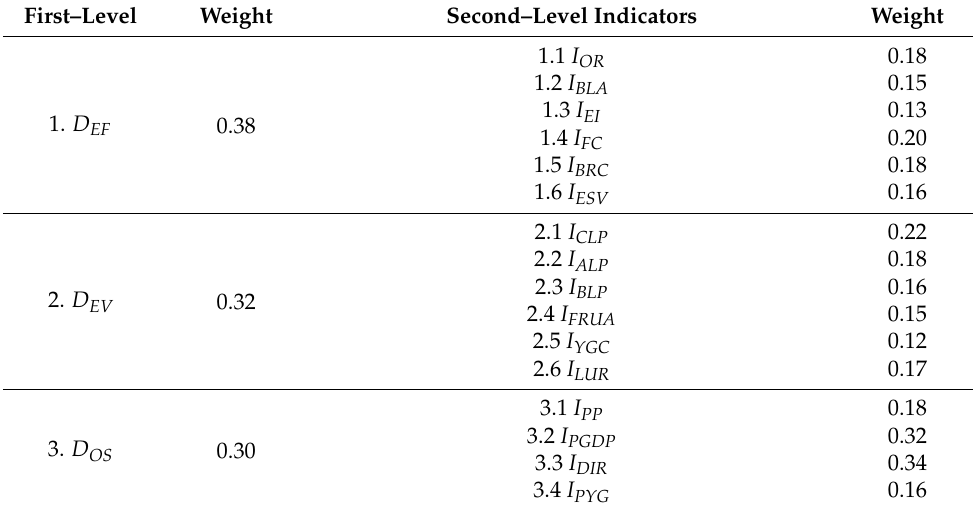
Table 3. Weights of indicators at all levels of regional